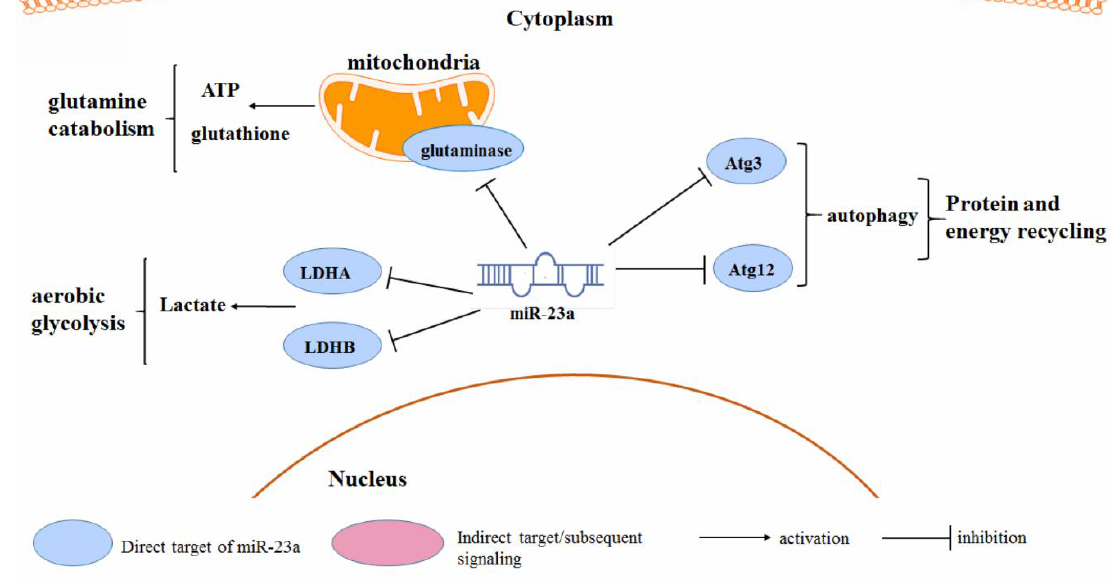
Figure 4. Regulation of miR-23a on the cancer cell metabolism.